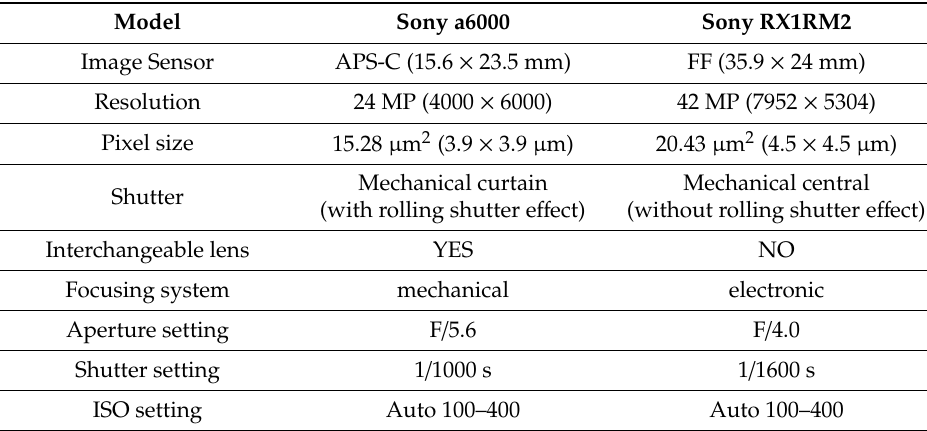
Table 3. Camera parameters.